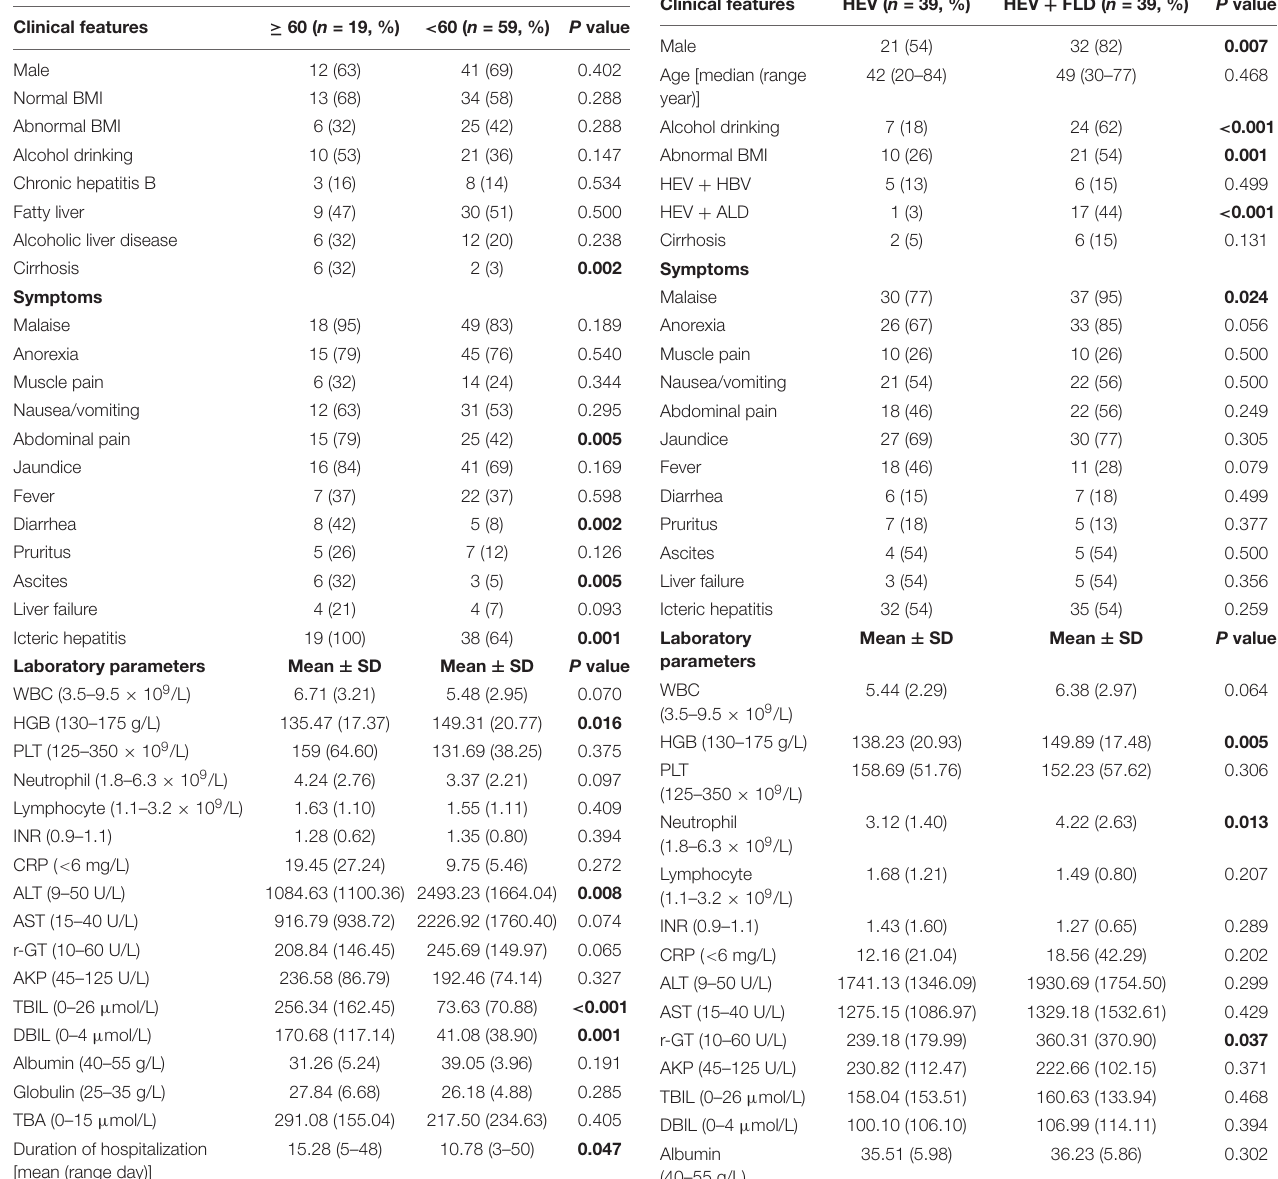
TABLE 3 | Patients demographics, clinical characteristics, and laboratory findings between HEV group and HEV + FLD